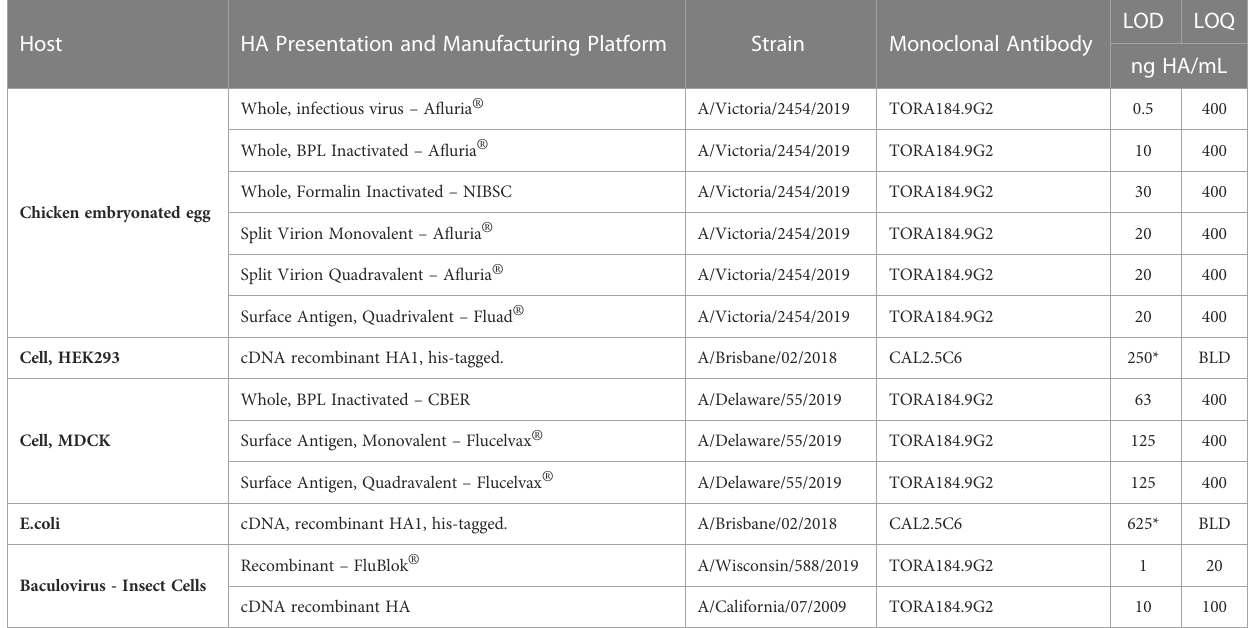
TABLE 6 Compatibility of ELISA with various in fl uenza vaccine platforms and HA expression vectors. Host HA Presentation and Manufacturing Platform Strain Monoclonal Antibody